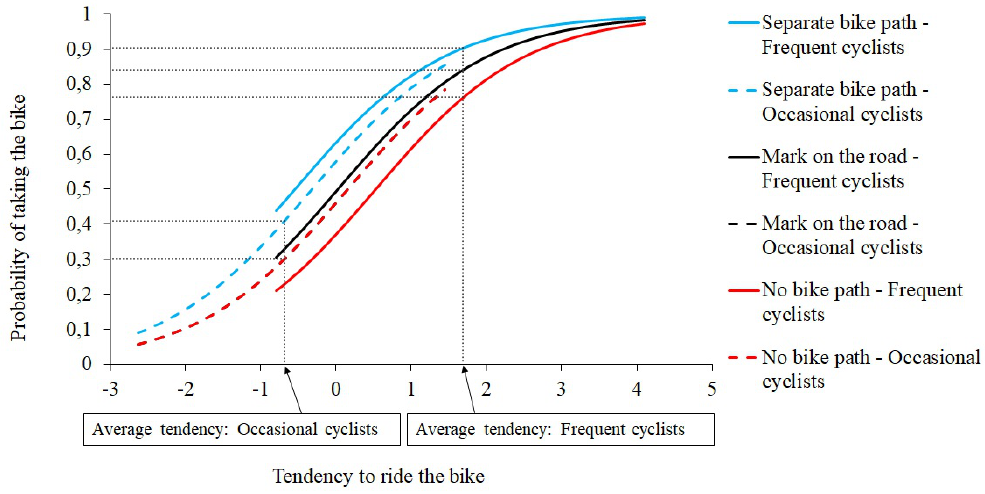
Figure 7. Probability of taking the bike for different types of bike